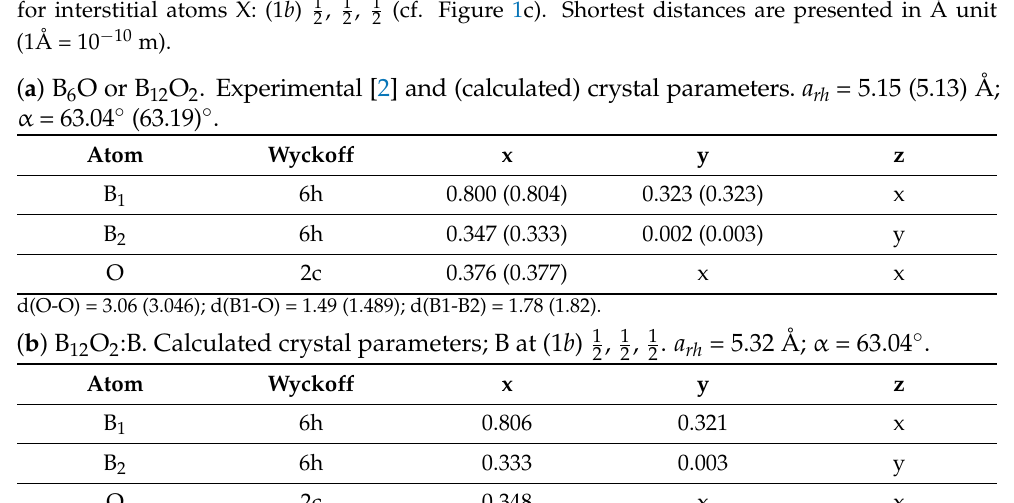
, 1 , 1 (cf. Figure 1c). Shortest distances are presented in Å unit 2 2 2